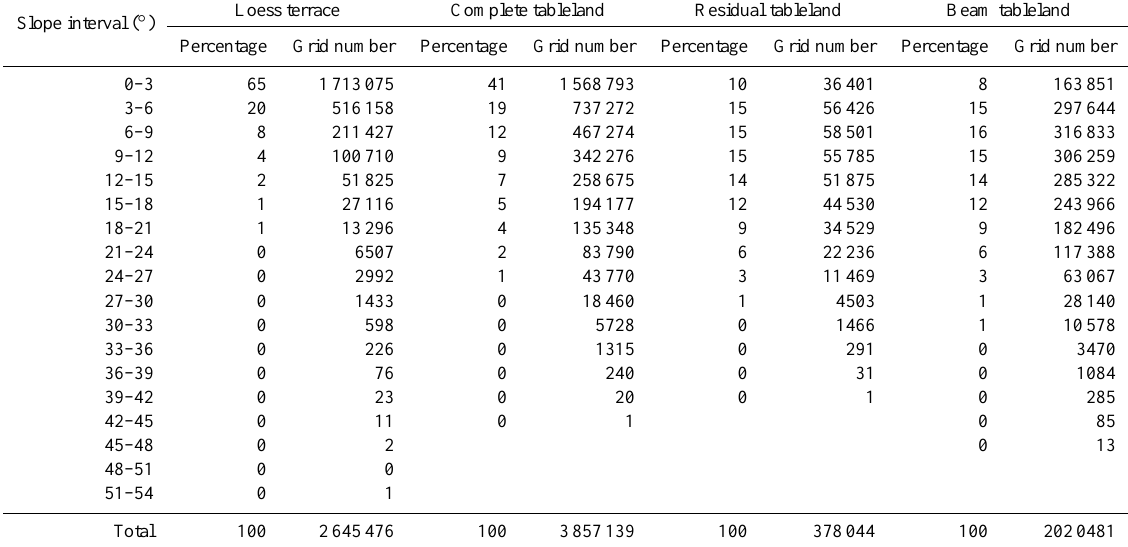
Table 3. Distribution status of the slope intervals for the subtypes of the loess tableland. Slope interval ( ◦